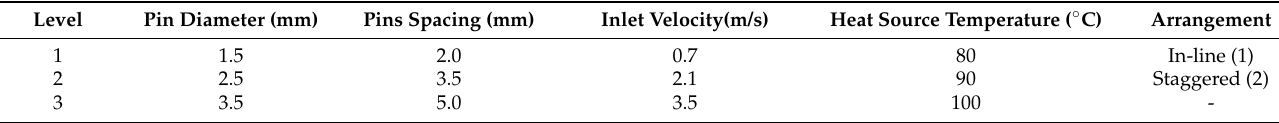
Table 3. Levels and factors for DOE matrix for pins heat